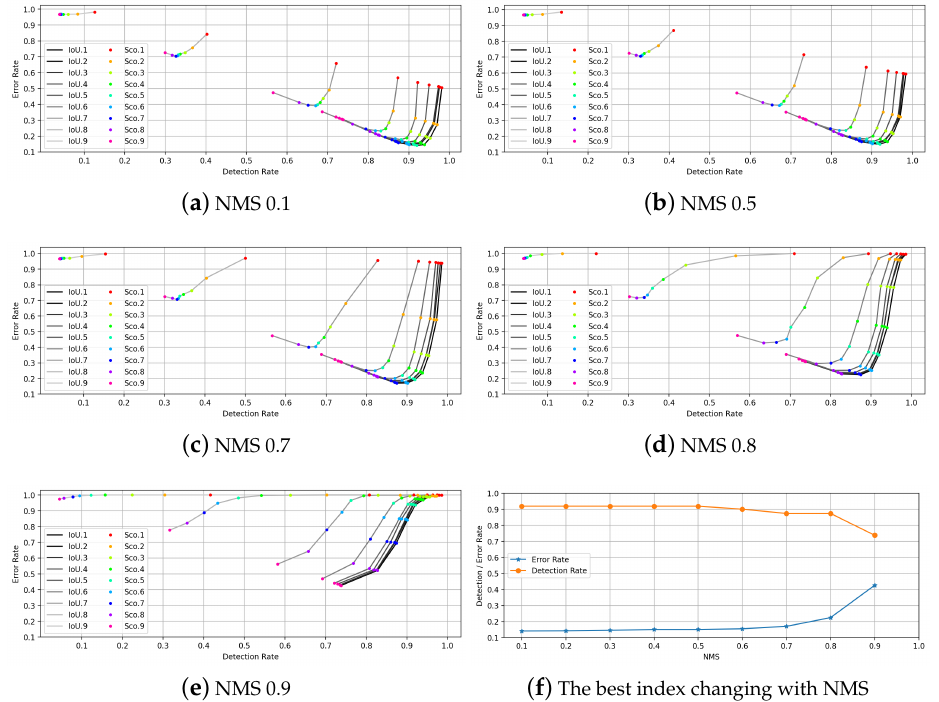
Figure 8. The curve of detection rate and false alarm rate with NMS, IoU, and confidence score. The last subplot represents the curve of the lowest false-alarm rate and its corresponding detection rate variation with the NMS threshold for the previous